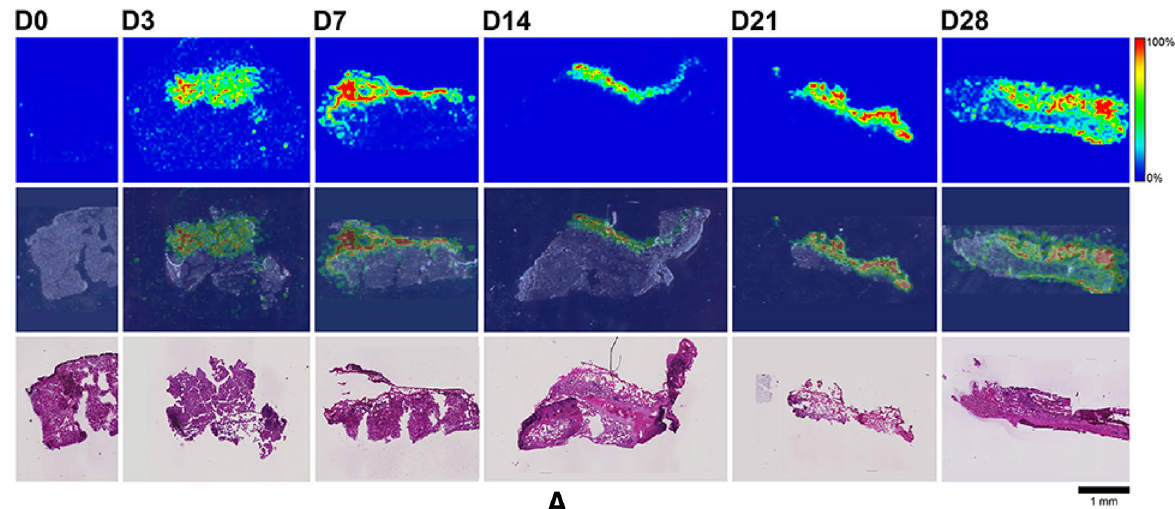
Figure 9. ( A ) Representative TAF spatial distribution profiles (positive mode, m/z 477 → 270, 346) in mouse dermal tissue sections adjacent to high-releasing (0.58 mg d -1 ) TAF implants; D0 indicates tissues from an unmedicated control; D3, D7, D14, D21, and D28 indicate tissue specimens collected with the TAF implant in place at study days 3, 7, 14, 21, and 28, respectively. The first row represents mass spectrometry images, generated at a spatial resolution of 50 µm and the color key in the legend indicates relative abundance, with red representing the highest signal intensity (100%) and blue representing the lowest signal (0%) for the measured ion; all images were scaled individually. The second row represents an overlay of the IMS signals and light microscopy images of the tissue specimens. The third row corresponds to H&E serial section stains of matching tissue specimens. Scale bar, 1 mm. ( B ). Representative Metabolite X spatial distribution profiles (positive mode, m/z 359 → 270, 288) in mouse dermal tissue sections adjacent to high-releasing (0.58 mg d -1 ) TAF implants. Additional details are the same as in ( A ). ( C ). Representative Metabolite Y spatial distribution profiles (positive mode, m/z 401 → 270) in mouse dermal tissue sections adjacent to high-releasing (0.58 mg d -1 ) TAF implants Additional details are the same as in ( A ). ( D ). Representative TFV spatial distribution profiles (negative mode, m/z 286 → 134, 151) in mouse dermal tissue sections adjacent to high-releasing (0.58 mg d -1 ) TAF implants. Additional details are the same as in ( A ). ( E ). Representative TFV-MP spatial distribution profiles (negative mode, m/z 366 → 268, 348) in mouse dermal tissue sections adjacent to high-releasing (0.58 mg d -1 ) TAF implants. Additional details are the same as in ( A ). ( F ). Representative TFV-DP spatial distribution profiles (negative mode, m/z 446 → 159, 348) in mouse dermal tissue sections adjacent to high-releasing (0.58 mg d -1 ) TAF implants. Additional details are the same as in ( A